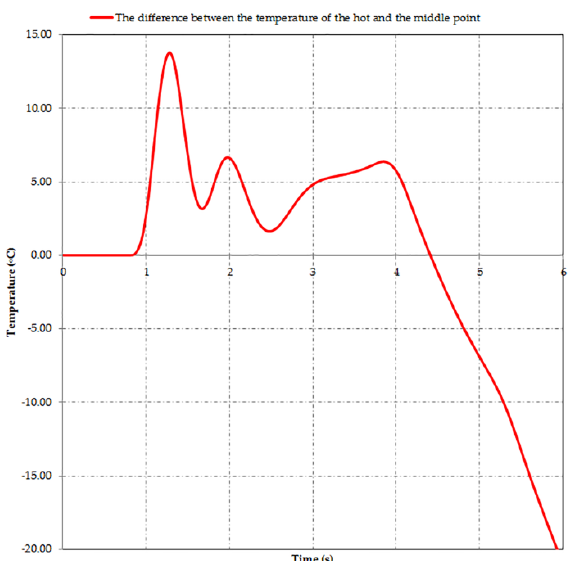
Figure 19. Difference between the temperature of the hot and middle point of the drum during braking.